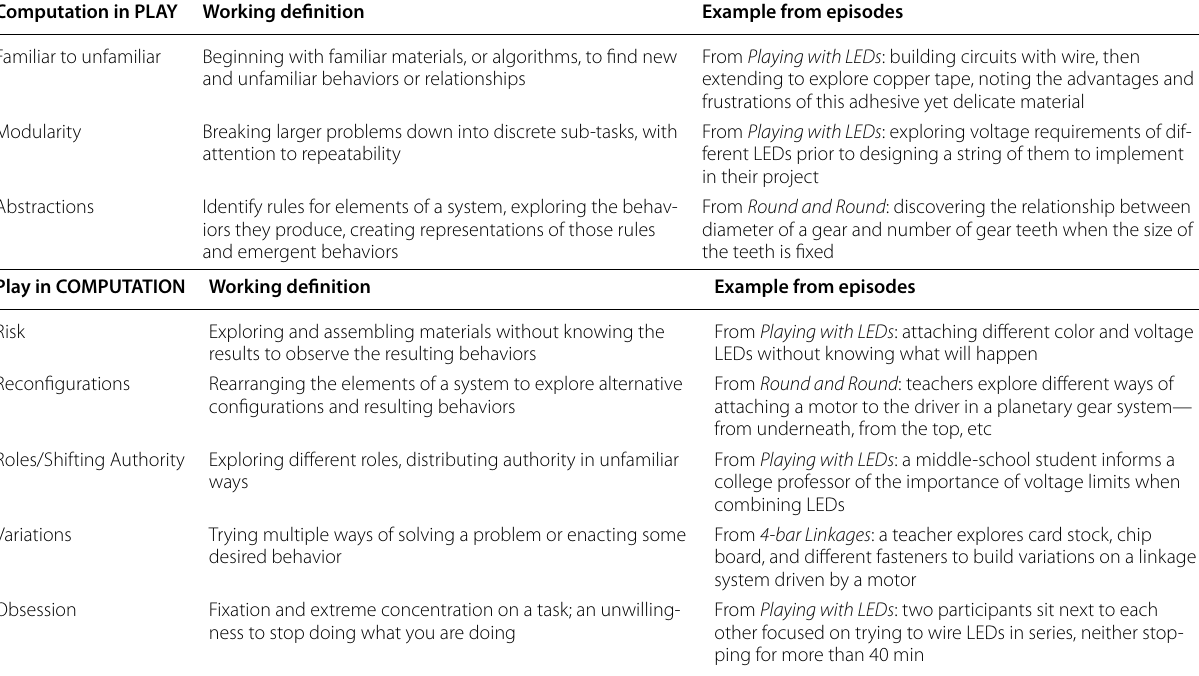
Table 2 Characteristics of computation in playful activity, and characteristics of play in computational activity, with examples from the identified